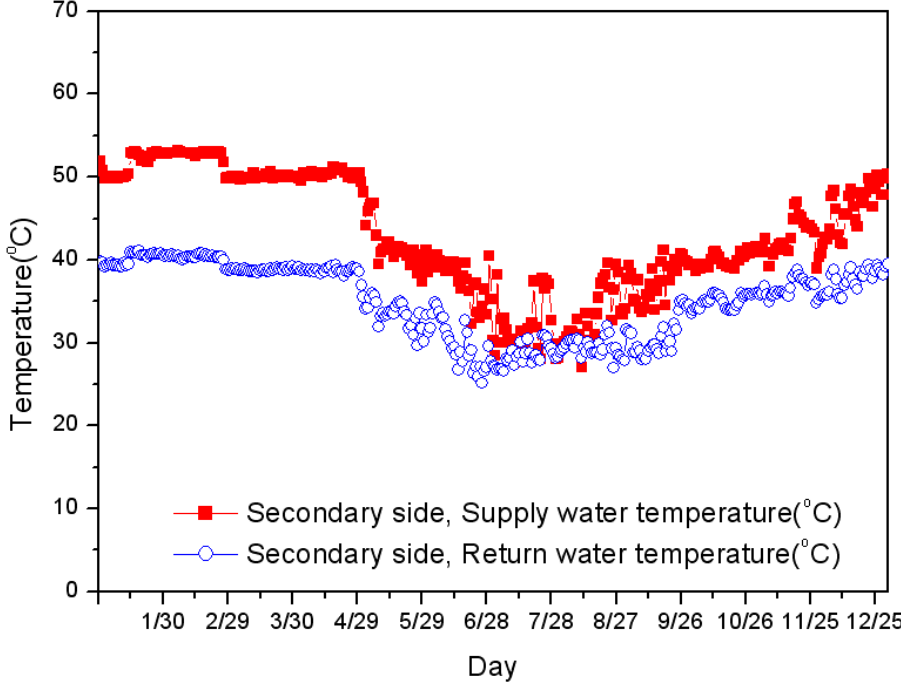
Figure 3. Annual variation of supply and return water temperatures of group energy secondary side (consumer side) of the model